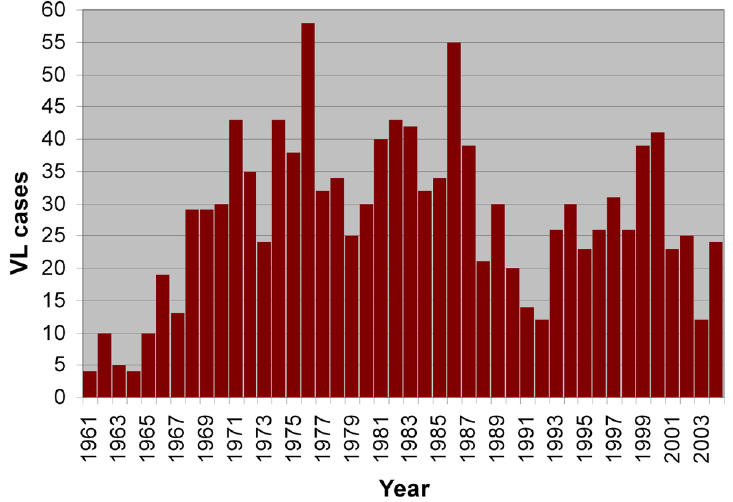
Figure 3. Temporal analysis of the VL cases for the period 1961–2004.